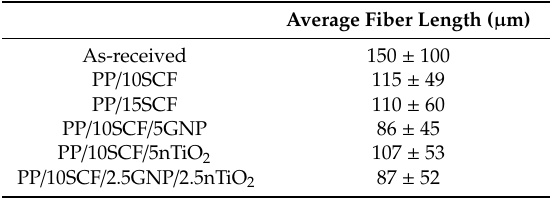
Table 4. Average fiber length, as-received, and after loading.